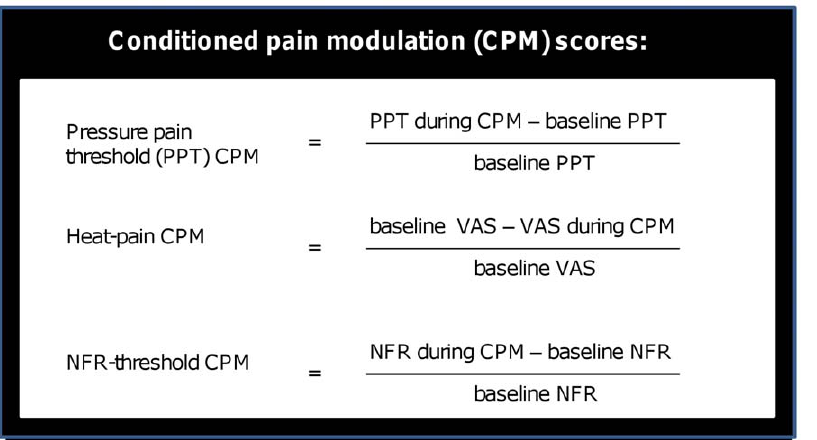
Figure 1. Conditioned pain modulation scores (CPM-scores). To control for individual variation with regard to baseline values, the proportion of difference from baseline was used rather than the difference of raw values. This was done to control for individual variation in baseline measures and gives positive CPM-scores for pain inhibition and negative ones for facilitation, as compared to the baseline. To enable a comparison of VAS- ratings with threshold values, we define our CPM-scores as q(b–c)/b where b=baseline value (in kPA, mm or mA) and c= value during CPM. q=1 for heat-pain VAS-ratings and q= 2 1 for thresholds ratings.